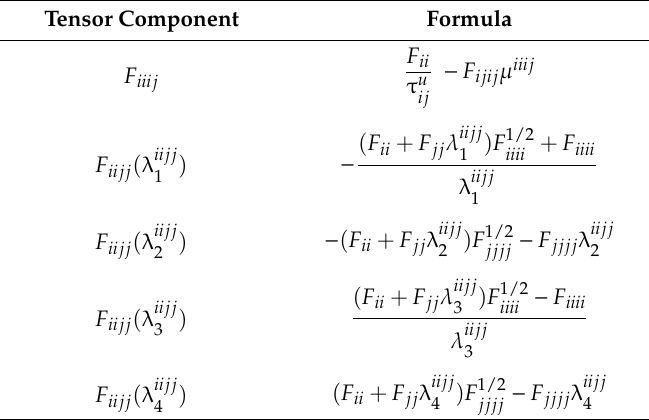
Table 1. Mathematical expressions for interaction stress components.